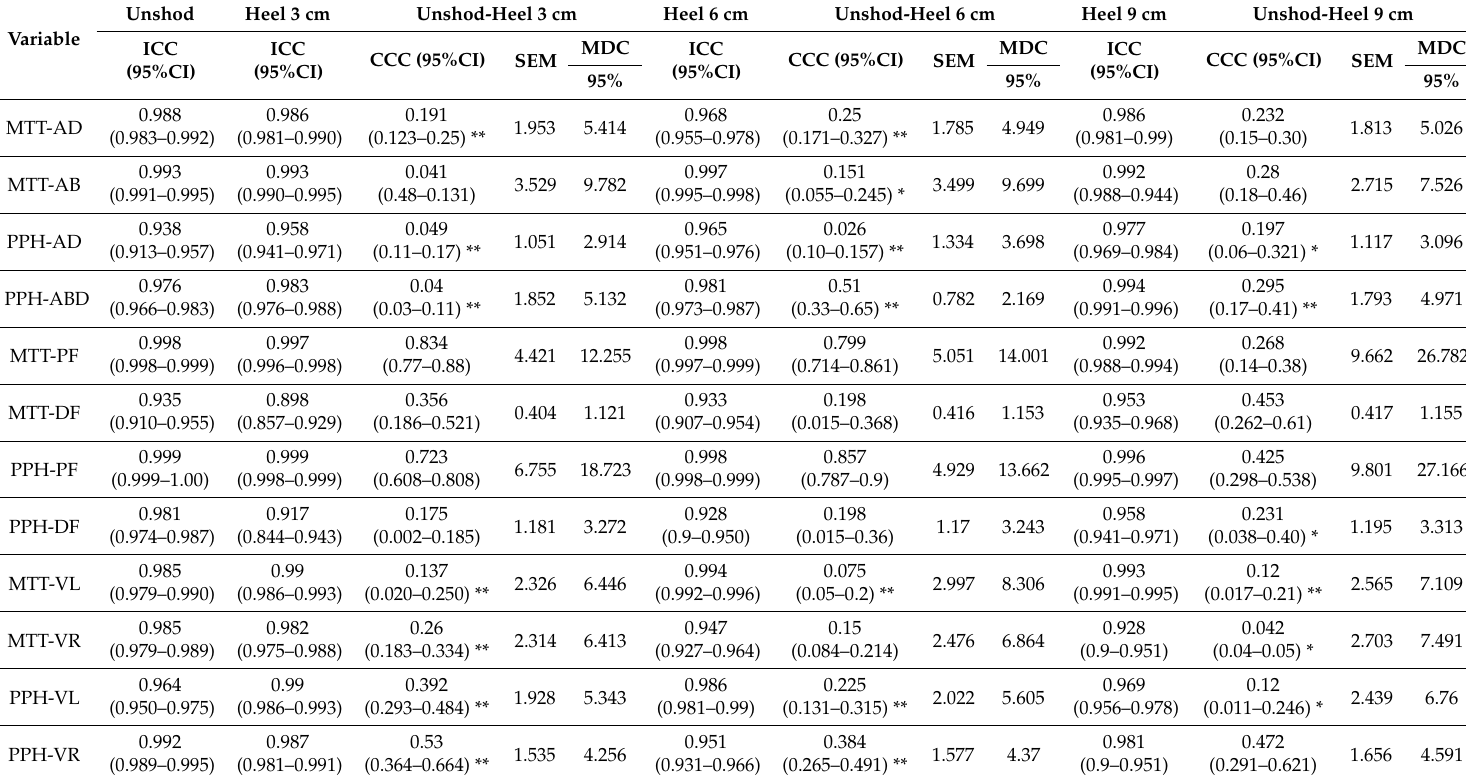
Table 3. Reliability ICC and CCC of dynamic variables in unshod versus heels that were 3 cm, 6 cm, or 9 cm